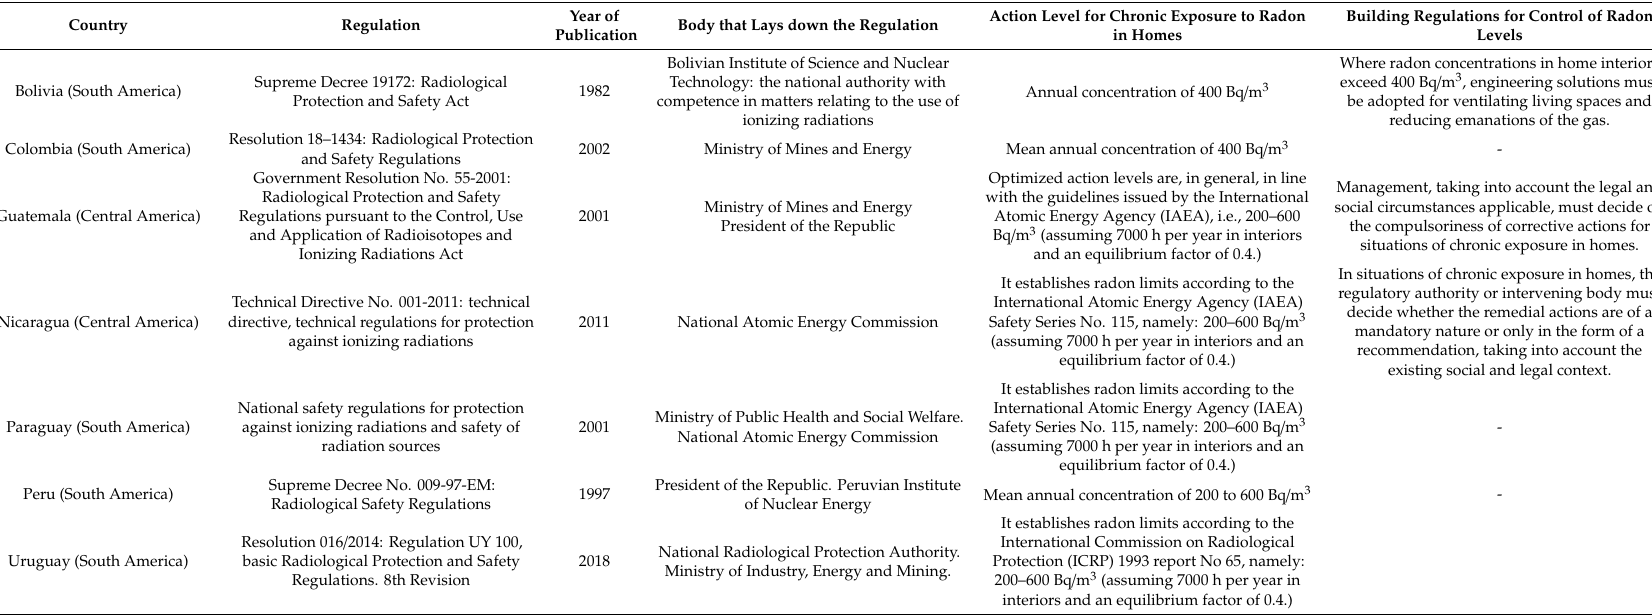
Table 2. Governmental regulations, ordinances, or plans governing residential radon exposure and home